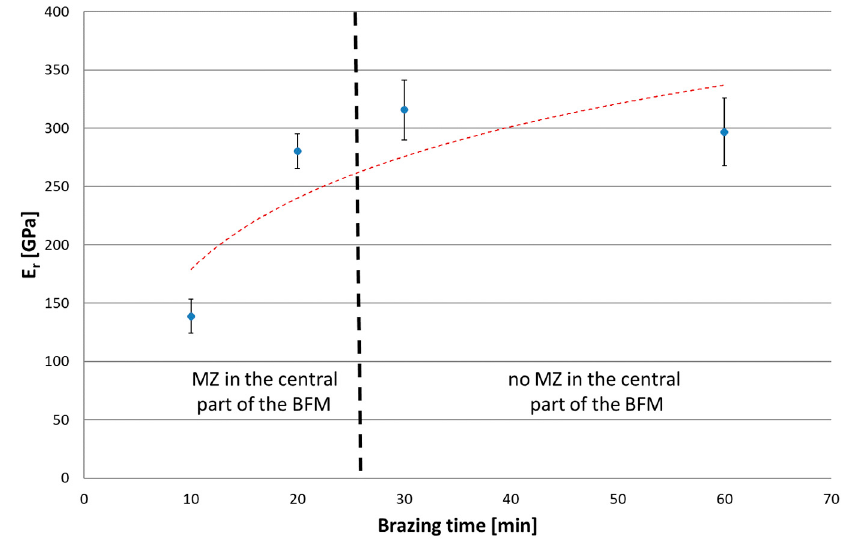
Figure 17. Reduced modulus of the indentation contact for Hastelloy X–Palnicro 36M joints by 1 N load.